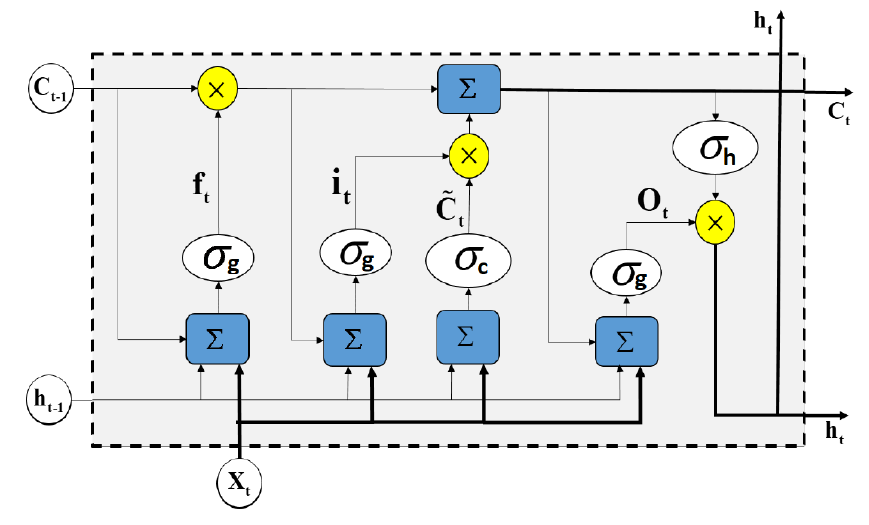
Figure 1. A typical architecture of an LSTM cell. An LSTM block typically has a memory cell, input gate ( i t ), output gate ( O t ), and a forget gate ( f t ) in addition to the hidden state ( h t ) in traditional RNNs